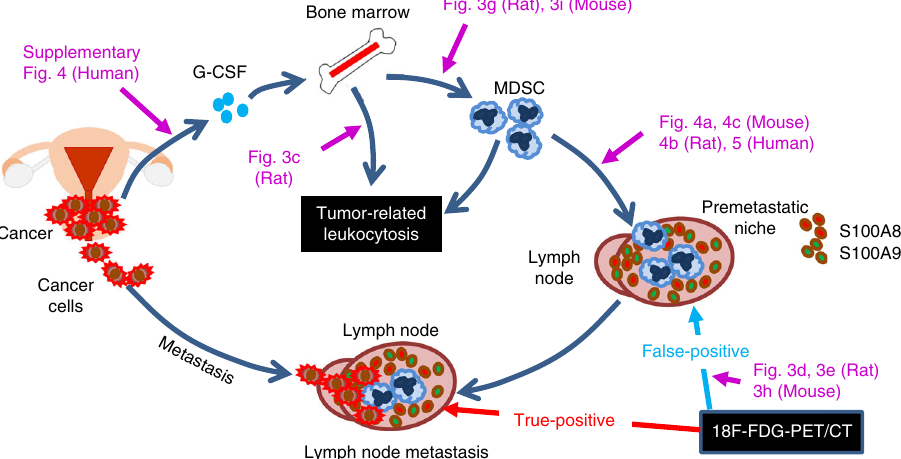
Fig. 2 Proposed mechanism of false-positive 18F-FDG-PET/CT results in TRL-positive gynecological cancer patients. MDSC-mediated premetastatic niche formation misleads 18F-FDG-PET/CT during lymph node